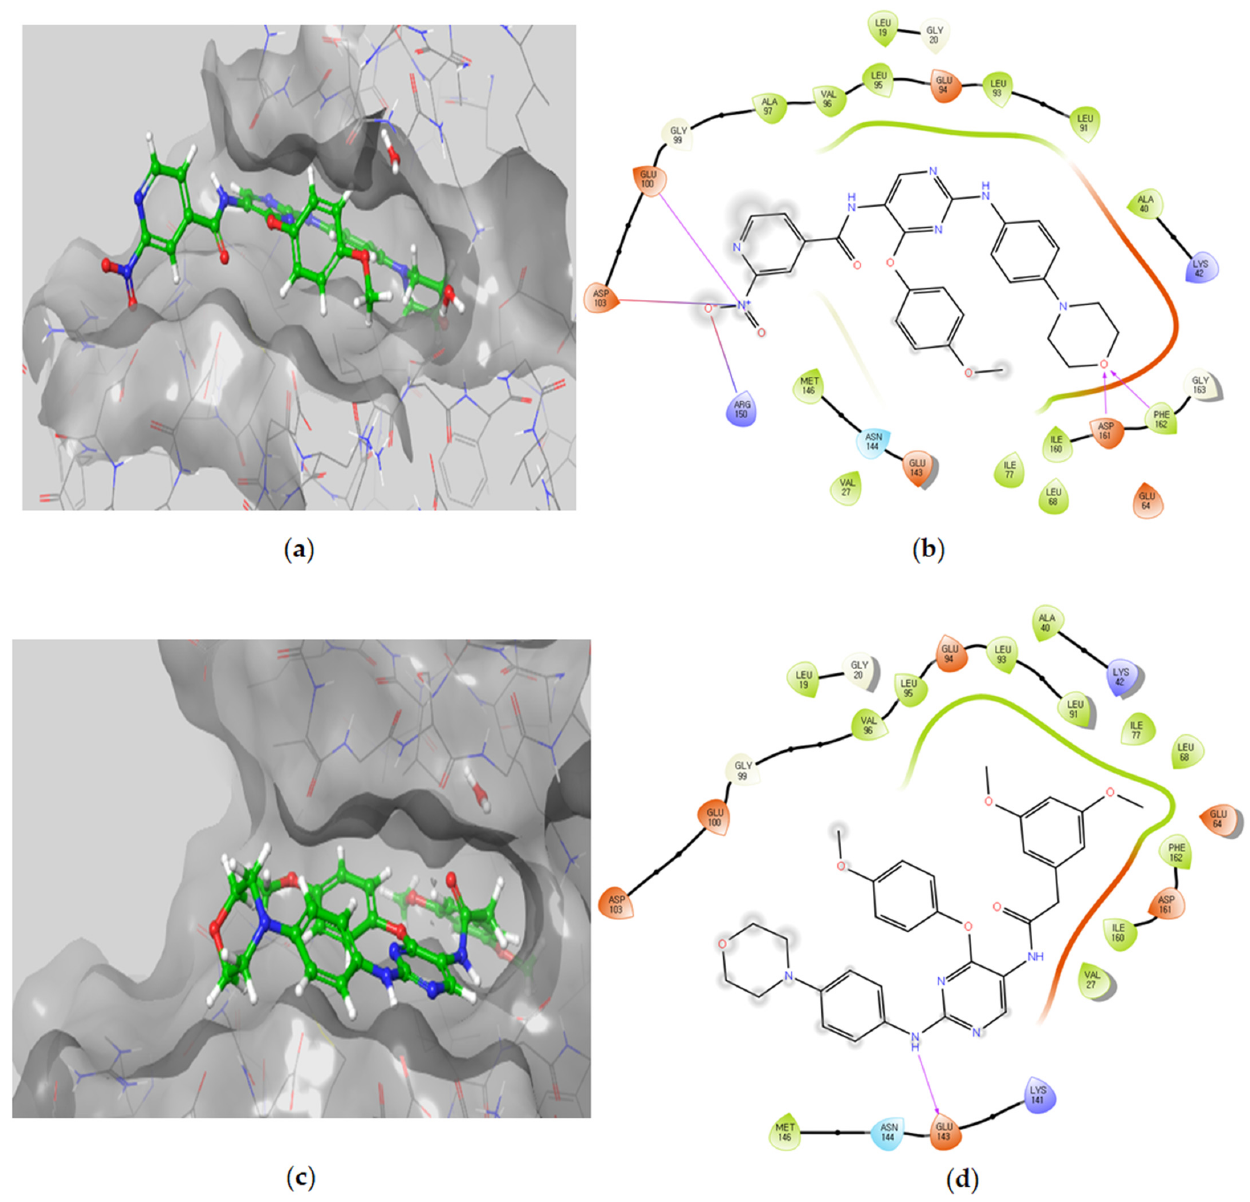
Figure 6. Docked complexes of compounds 5f and 5e with DAPK1. ( a , c ) 3D docking models of compounds 5f and 5e into DAPK1 binding pocket, respectively. ( b , d ) 2D interaction diagrams of compounds 5f and 5e with DAPK1, respectively.